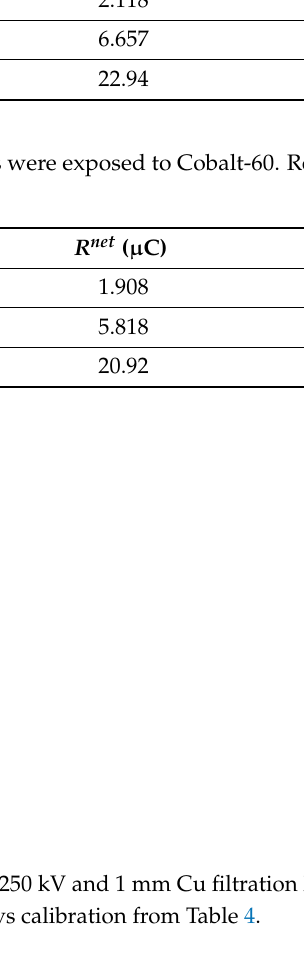
Table 2. Measured net values for each dose point when TLDs were exposed to Cesium-137. Relative uncertainties on 𝑅 (cid:3041)(cid:3032)(cid:3047) are expressed in Table 4.